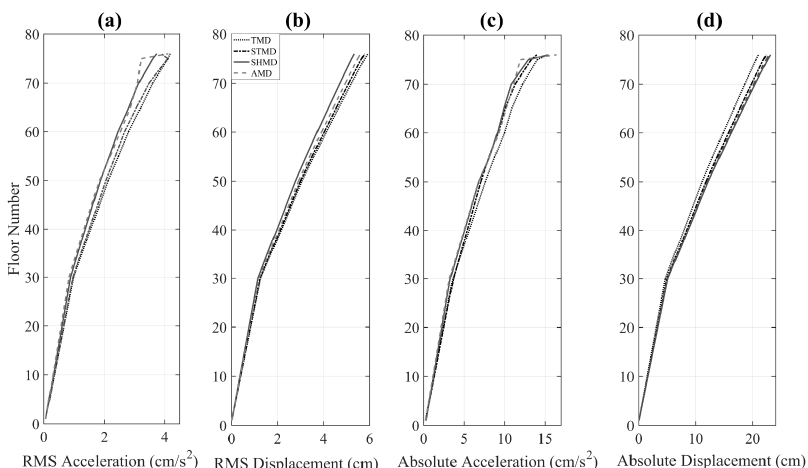
Figure 12. Illustration of the performance of different control measures in terms of ( a ) RMS acceleration; ( b ) RMS displacement; ( c ) absolute acceleration; and ( d ) absolute displacement at different floor levels.